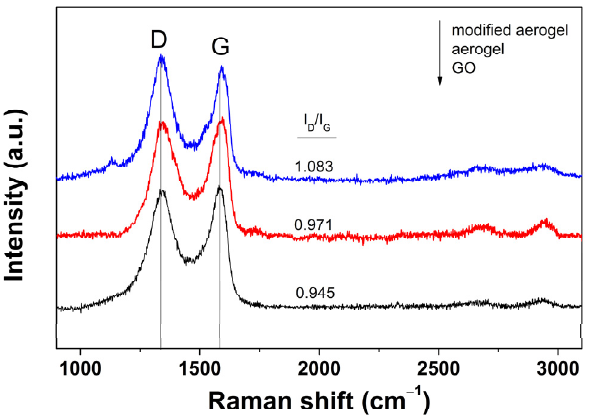
Figure 6. Raman spectra of initial GO dispersion and aerogels before and after dendrimer modifi- cation.